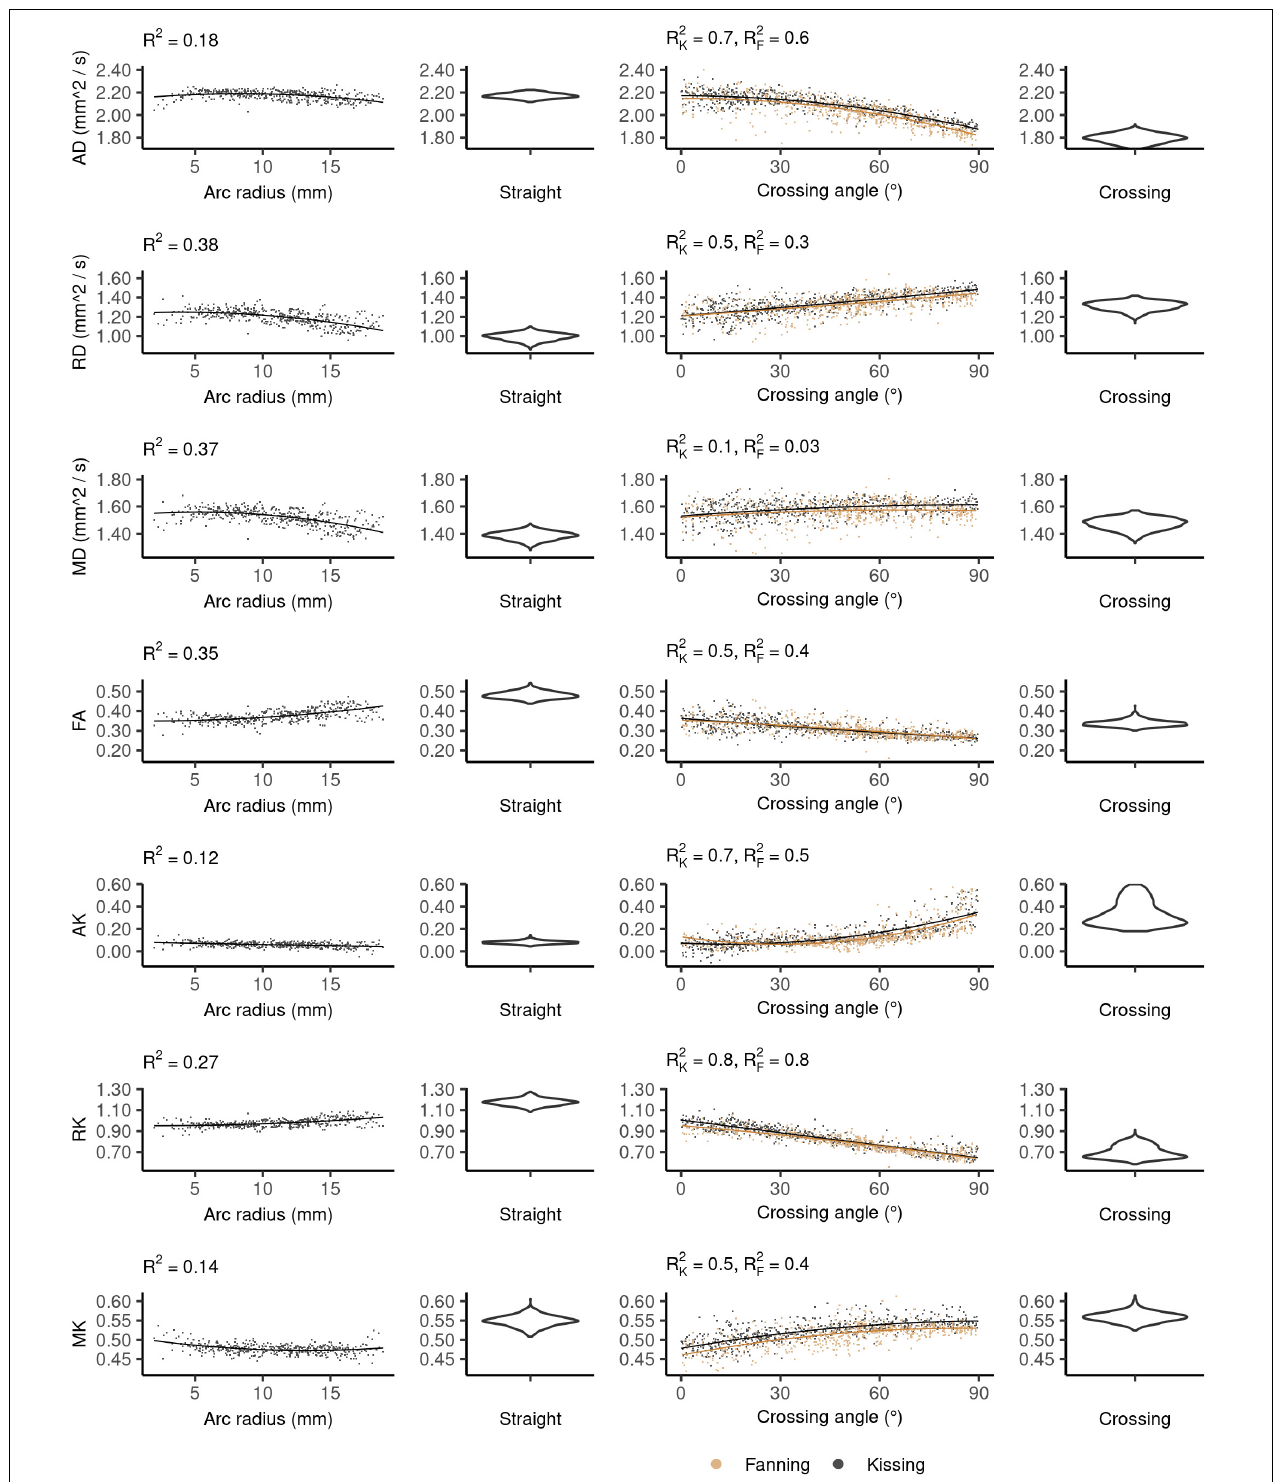
FIGURE 5 | Diffusion kurtosis imaging (DKI) metrics vs. orientation dispersion metrics in each of the four phantoms. Each row depicts the relationship between one metric and orientation dispersion, and each column depicts the data from one or two phantoms. From left to right, those phantoms are: bending, straight, fanning and kissing, and crossing. The violin plots shown for the straight and crossing phantoms depict the probability density of values observed in the voxels of those phantoms.